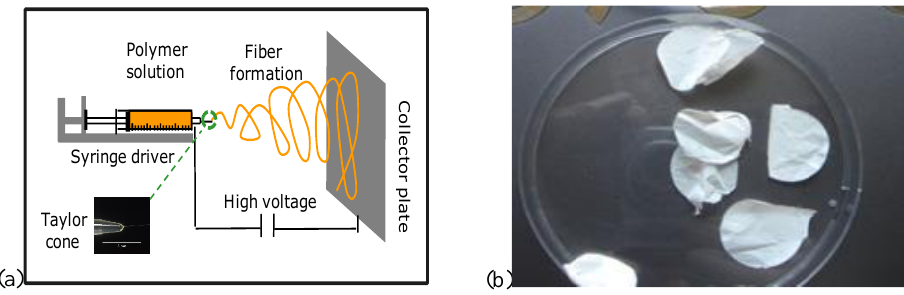
Figure 1. Electrospinning technique sketch ( a ) and collected CsU-based mats ( b ).